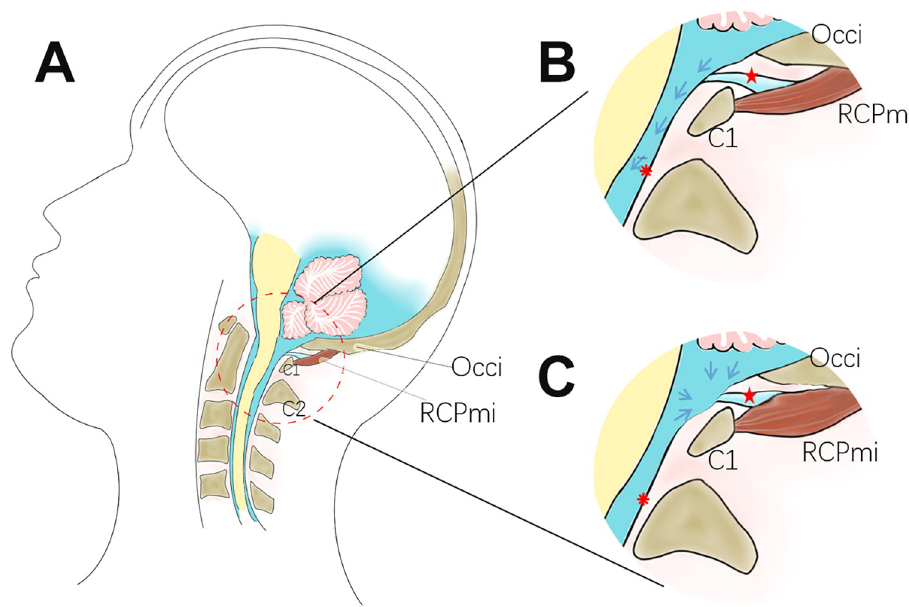
Fig 5. Hyperplasia of suboccipital muscles affects the CSF movement via the MDB. A. the CSF circulation at normal physiological state; B. enlarged view of the red circled region of A., the blue arrows indicate normal dynamics of CSF circulation. C. At the state of hyperplasia of the RCPmi, the MDB is passively stretched to change the volume of the subarachnoid space at the cervical level. C1: atlas; C2: axis; Occi: Occiput; RCPmi: rectus capitis posterior minor; red asterisk: cervical dura mater; red star: MDB (myodural bridge).